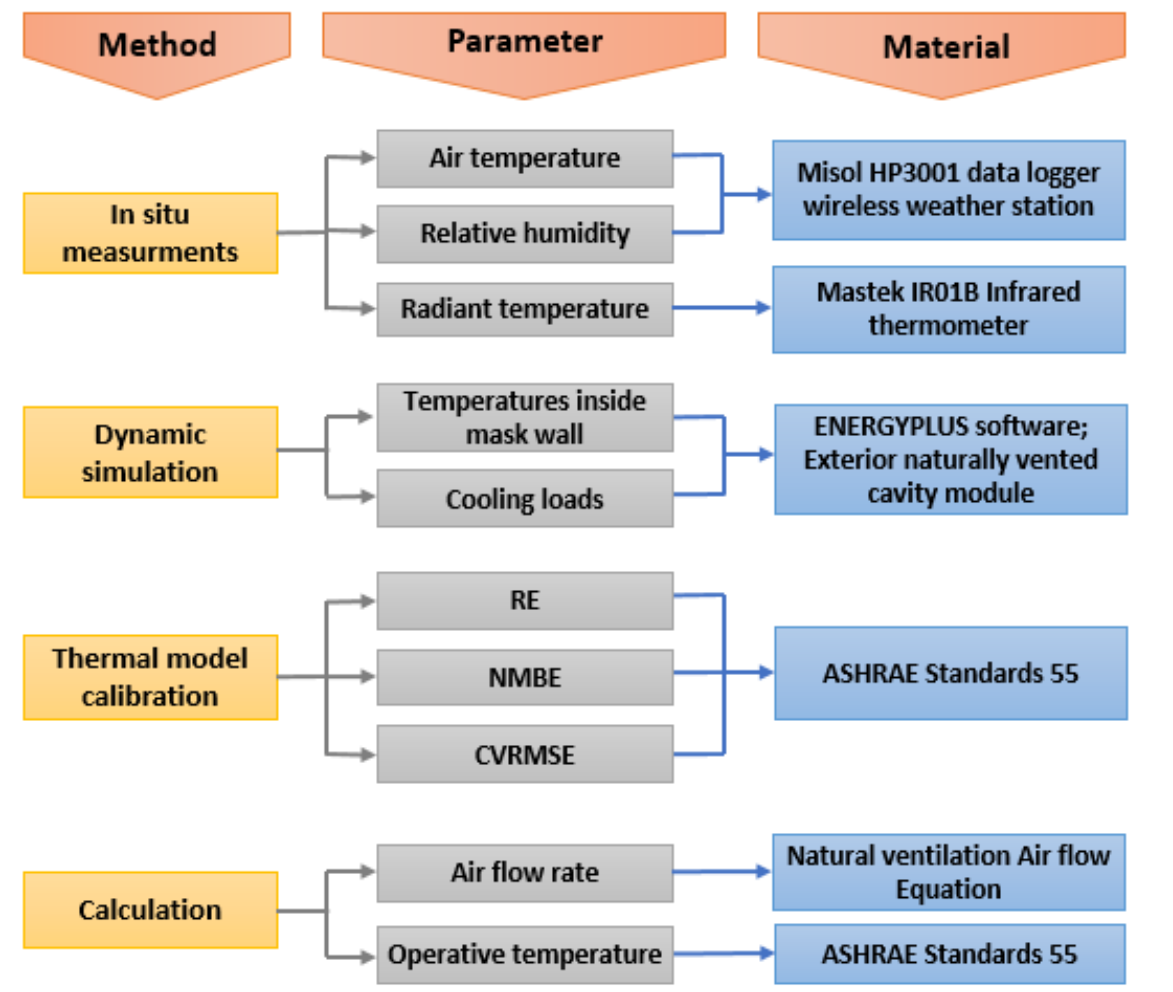
Figure 9. Flow chart of materials and methods.